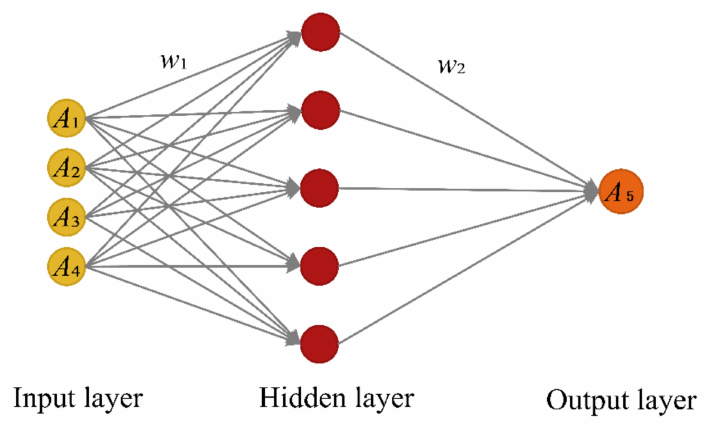
Figure 7. Grid structure of SSA-BPNN